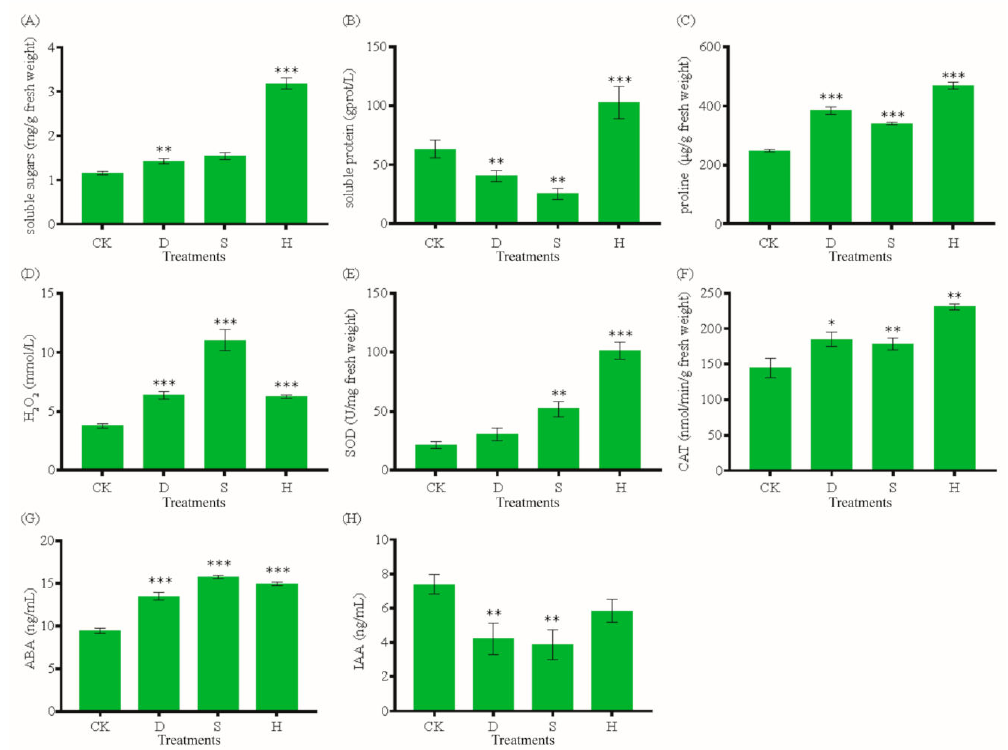
Figure 1. Physiological and biochemical characteristics of G. biloba under stress treatments. ( A ) Soluble sugars, ( B ) soluble proteins, ( C ) proline, ( D ) H 2 O 2 , ( E ) SOD, ( F ) CAT, ( G ) ABA, and ( H ) IAA. Error bars represent the mean ± SD; n = 3; * / ** / ***, p < 0.05 / 0.01 / 0.001, respectively, compared with CK. CK: Control; D: Drought; S: Salt; H: Heat; SOD: Superoxide dismutase; CAT: Catalase; ABA: Abscisic acid; IAA: Indole-3-acetic